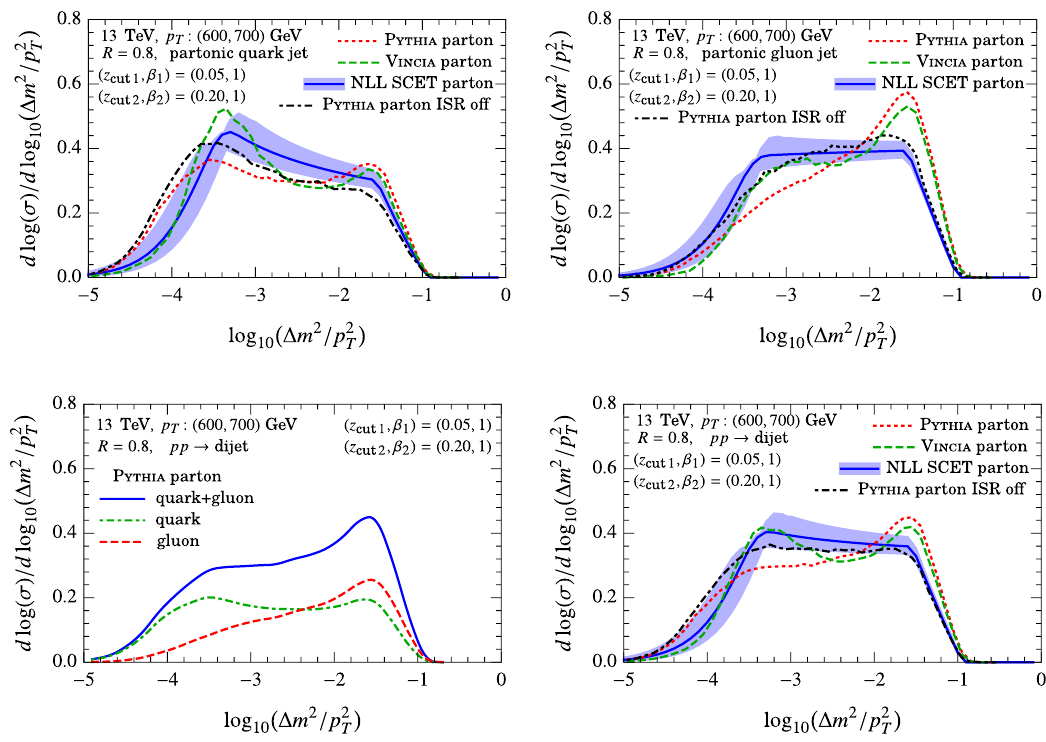
Figure 19 . Collinear Drop distributions with ( z cut1 ; (cid:12) 1 ) = (0 : 05 ; 1) and ( z cut2 ; (cid:12) 2 ) = (0 : 2 ; 1) from Pythia and Vincia simulations as well as SCET calculations with theoretical uncertainty estimation (blue bands). Results from Pythia simulations with initial state radiation turned o(cid:11) are also provided. The top two panels show the distributions for quark-initiated jets (left panel) and gluon-initiated jets (right panel), and the bottom right panel gives the dijet distributions. The bottom left panel gives a decomposition of the Collinear Drop distribution from Pythia simulations into quark and gluon